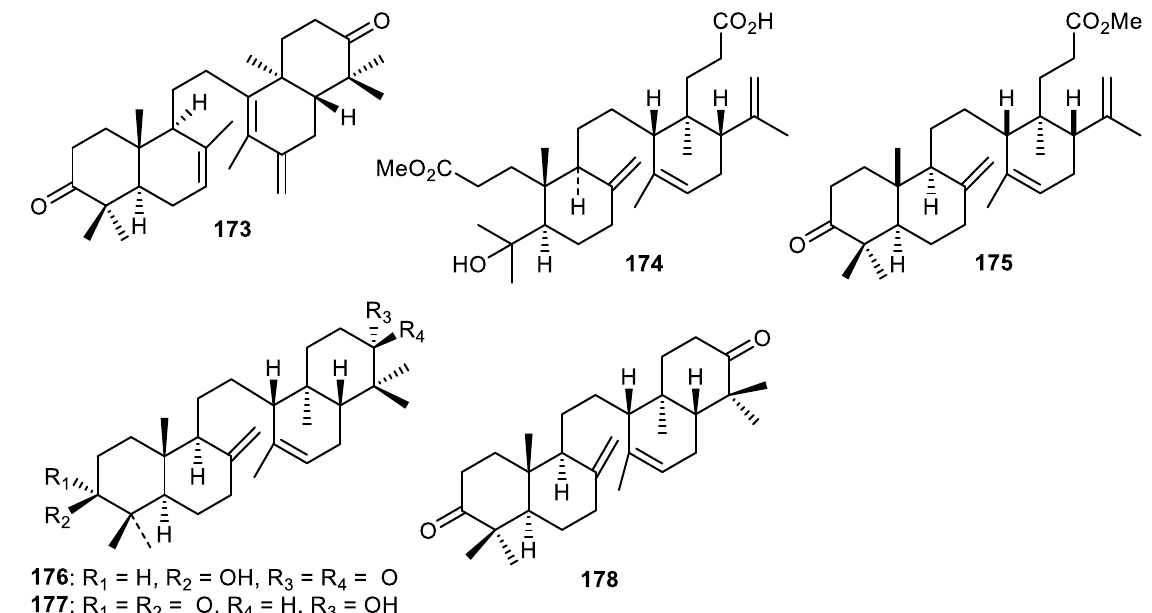
Figure 21. Structures of onocerane triterpenoids 173 – 178 .